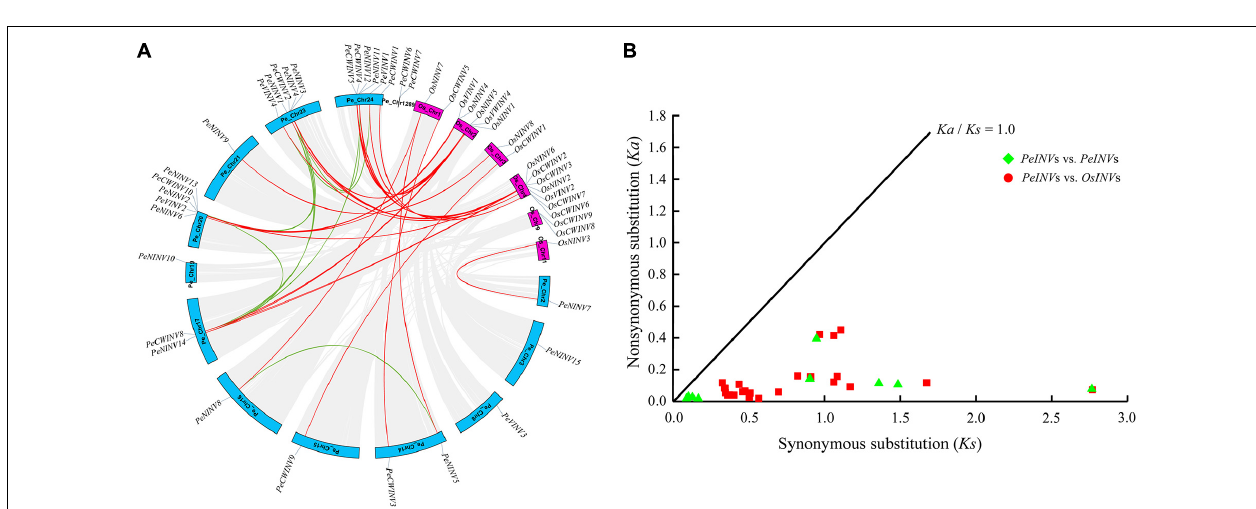
FIGURE 4 | Synteny regions and Ka / Ks ratios analyses of INV genes. (A) Chromosome location and synteny regions of all PeINV s and OsINV s. The duplicated genes of PeINV s and PeINV s/ OsINV s on different chromosomes were indicated with green and red lines, respectively. (B) The Ka / Ks ratios of INV homologous gene pairs.